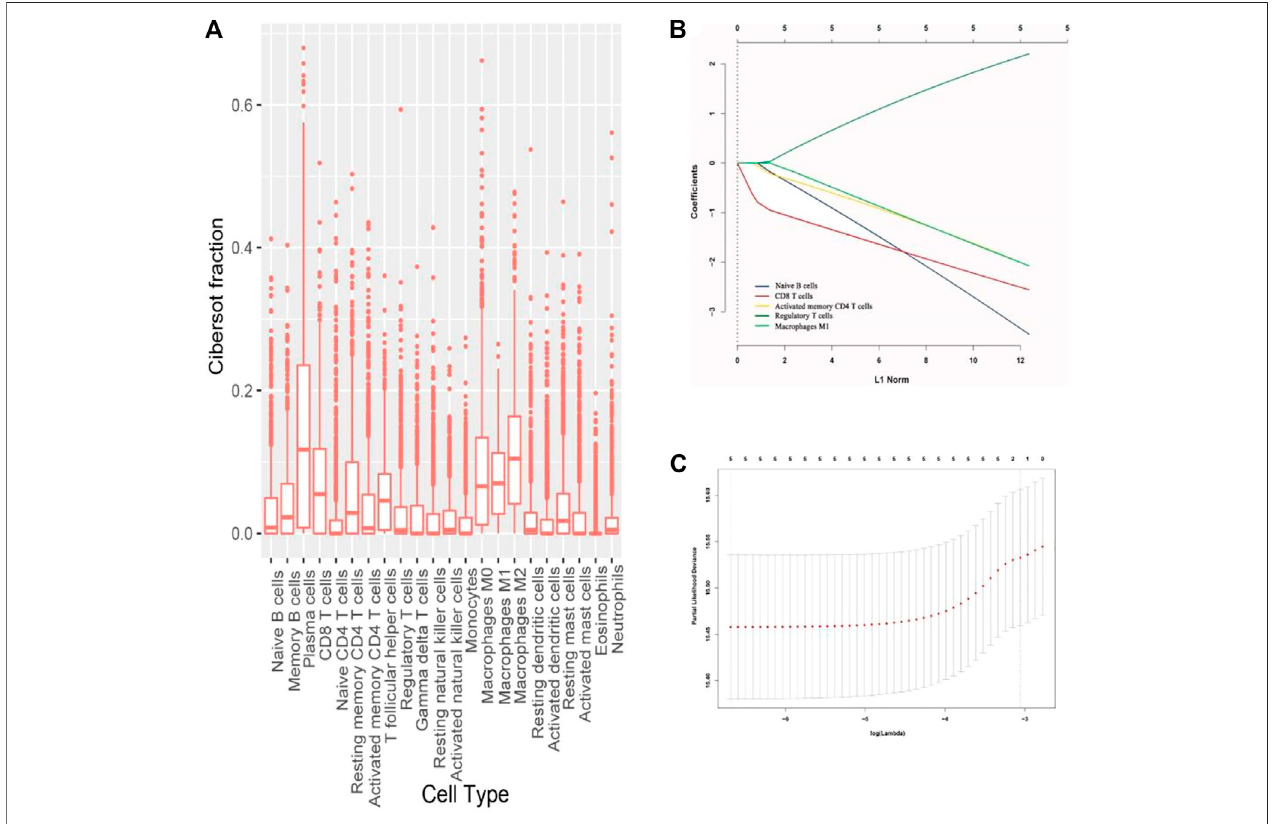
FIGURE 1 | (A) Fraction data of the 22 types of immune cells. (B) LASSO coef fi cient pro fi les of the fi ve selected stromal features for overall survival. (C) Partial likelihood deviance of the LASSO coef fi cient pro fi les for overall